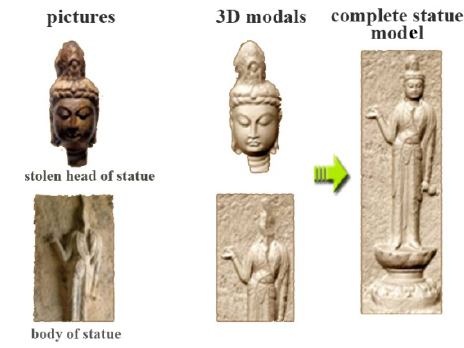
Fig.14 Digital reconstruction of head and body of a